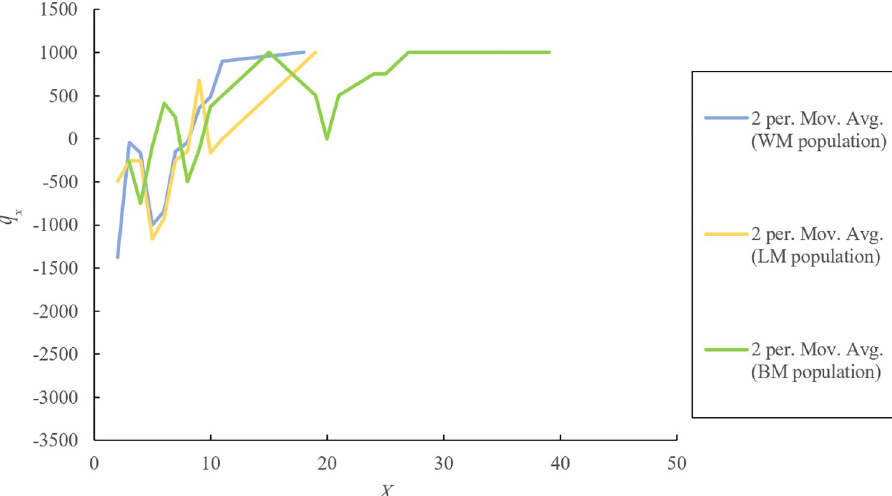
Fig 5. Survival curves of three P . flavus